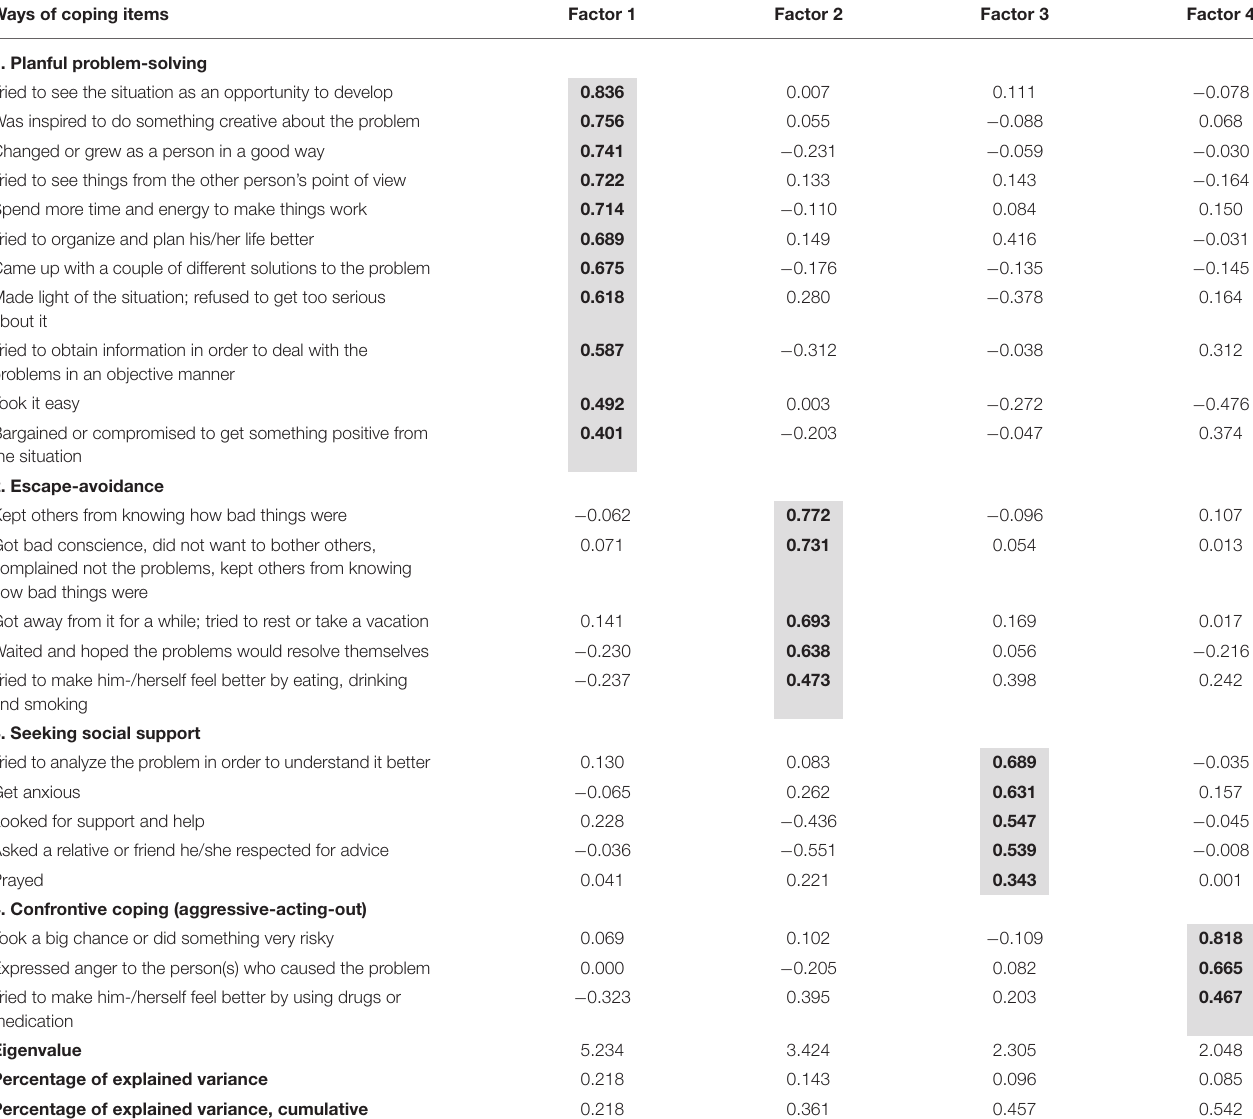
TABLE 1 | Factor analysis of ways of coping with oblimin rotation (factor loadings, eigenvalue and percentage of explored variance). Ways of coping